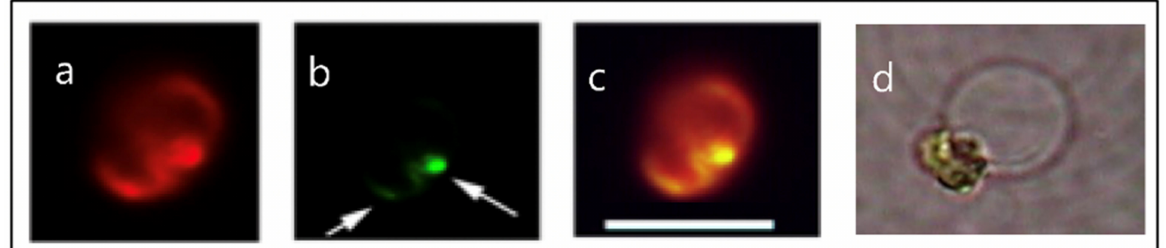
Figure 3. Fluorescence images of Phaeocystis globosa taken with excitation at λ ex = 494 nm wavelength that induces emission of both chlorophyll in the chloroplast, that fluoresces bright red (Panel a ), and of the secretory granules labeled LysoSensor— a probe that binds specifically to secretory granules—that fluoresces in green. The green granules indicated by arrows (Panel b ) are almost at the limit of resolution of the optical microscope. A few can be distinguished individually, and most of them—like in this case—are clustered inside the cell. Panel ( c ) is the merged image of ( a ) and ( b ). Depending on [Ca 2+ ] and pH in SW, the dimensions of the swollen exocytosed MBP matrix (Panel d ) can vary from ~3–12 µ m. Bar = 8 µ m.